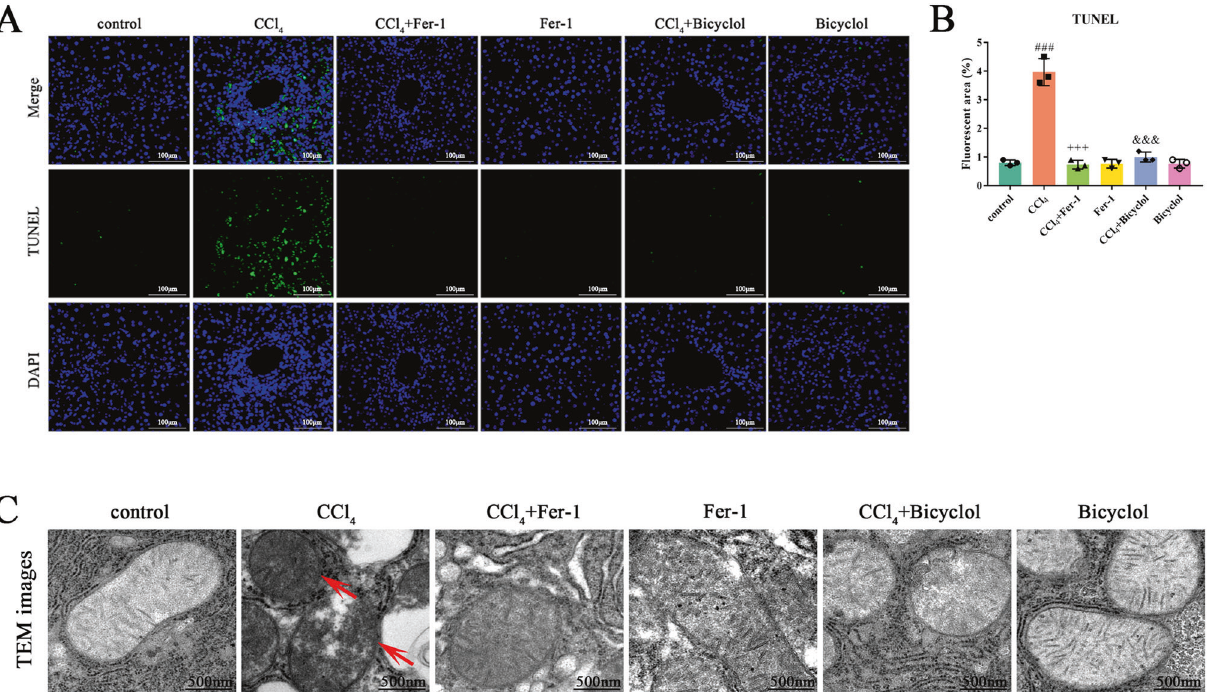
Fig. 2 Bicyclol inhibits CCl 4 -induced hepatocellular ferroptosis in vivo. A The dead hepatocytes were monitored by TUNEL staining in fi xed liver tissue sections. Representative images were shown. B Quanti fi cation of TUNEL-positive cells was shown. C TEM was used to detect the mitochondrial morphology of ferroptotic cells in liver tissue (red arrow). Data were expressed as mean ± SD. ### p < 0.001 vs control group, +++ p < 0.001 vs CCl 4 group, &&& p < 0.001 vs CCl 4